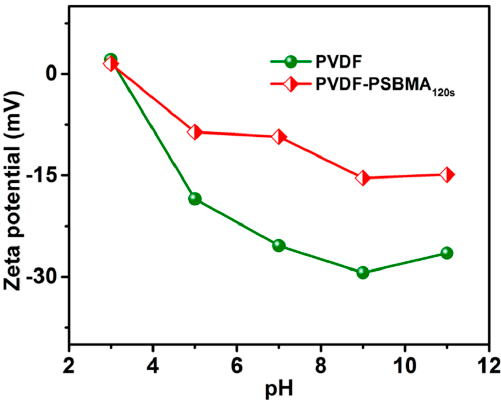
Figure 4. Zeta potential of unmodified PVDF and PVDF-PSBMA 120s membranes in different pH